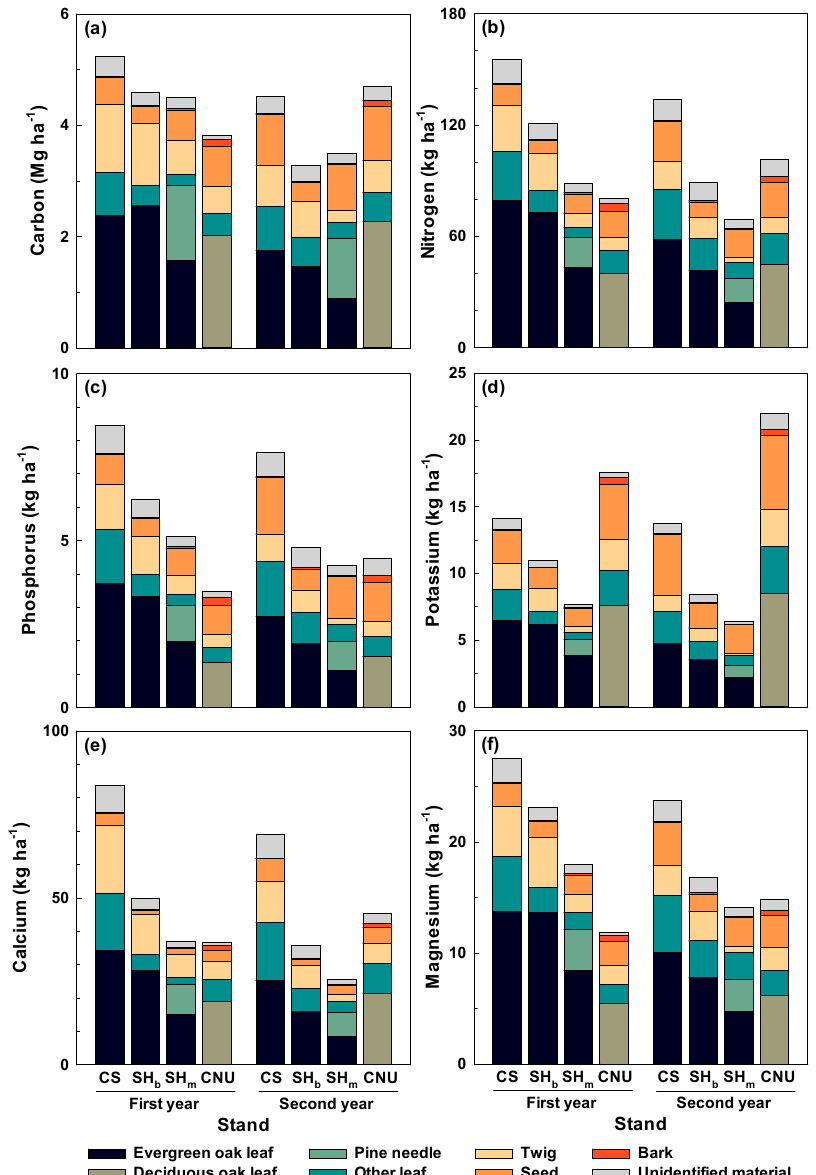
Figure 4. Annual ( a ) carbon, ( b ) nitrogen, ( c ) phosphorus, ( d ) potassium, ( e ) calcium, and ( f ) magnesium content of litterfall in evergreen broadleaved forest at Cheongsu (CS), evergreen broadleaved forest at Seonheul (SH b ), mixed forest at Seonheul (SH m ), and deciduous broadleaved forest at Chungnam National University (CNU) from August 2016 to August 2018. First and second year indicate the period from August 19, 2016 to August 23, 2017 and from August 24, 2017 to August 21, 2018, respectively. Evergreen oak leaf includes Quercus glauca and Q. salicina in CS, SH b , and SH m . Pine needle in SH m represents needle litter of Pinus thunbergii . Deciduous oak leaf in CNU represents leaf litter of Q. acutissima